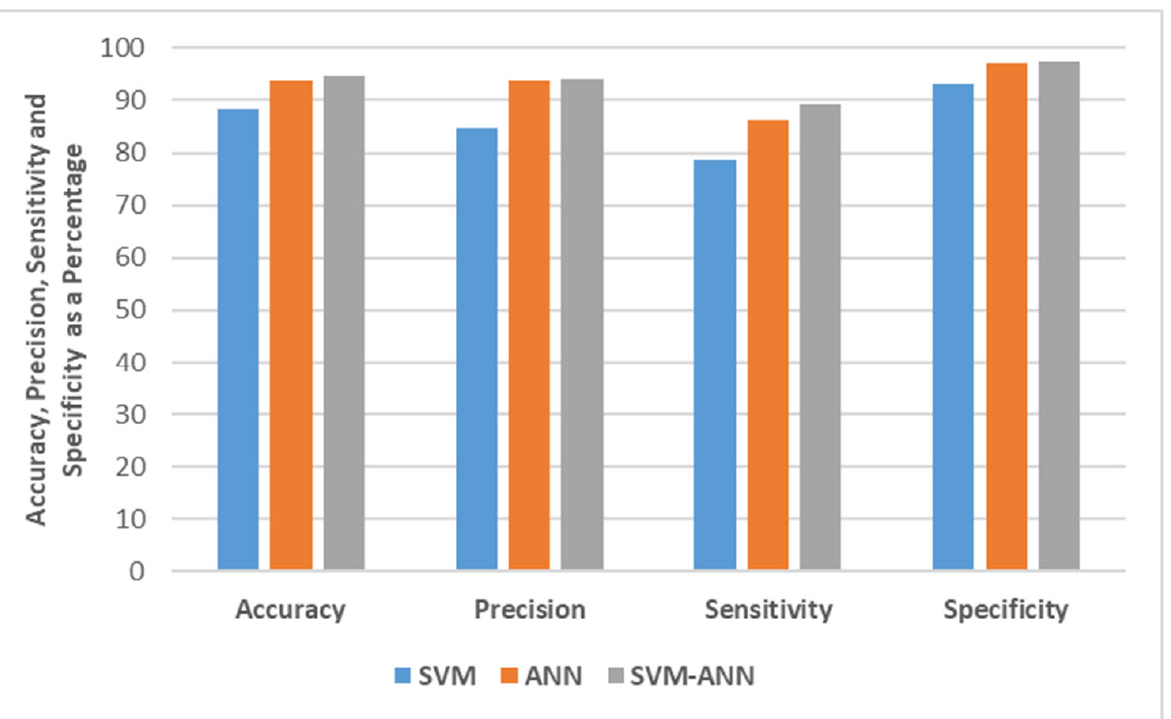
Figure 4. Comparison in terms of Accuracy, Precision, Sensitivity, and Specificity. A comparison of the performance of the fusion-based system with models reported in the literature in terms of accuracy is shown in Figure 5. Results demonstrate that the architecture reported here yields an increase in the accuracy of the classification of diabetes with ~1.8% improvement compared to the best performing